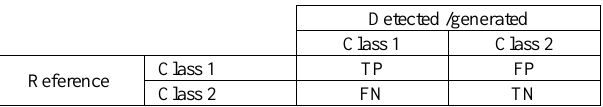
Table 2: Confusion matrix for evaluation of results The confusion matrix in shadow detection includes: true positive (TP) number of correctly classified shadow pixels, false positive (FP) number of wrongly classified non-shadow pixels as shadow, false negative (FN) number of shadow pixels which detected as non-shadow, and true negative (TN) number of non- shadow pixels classified correctly.